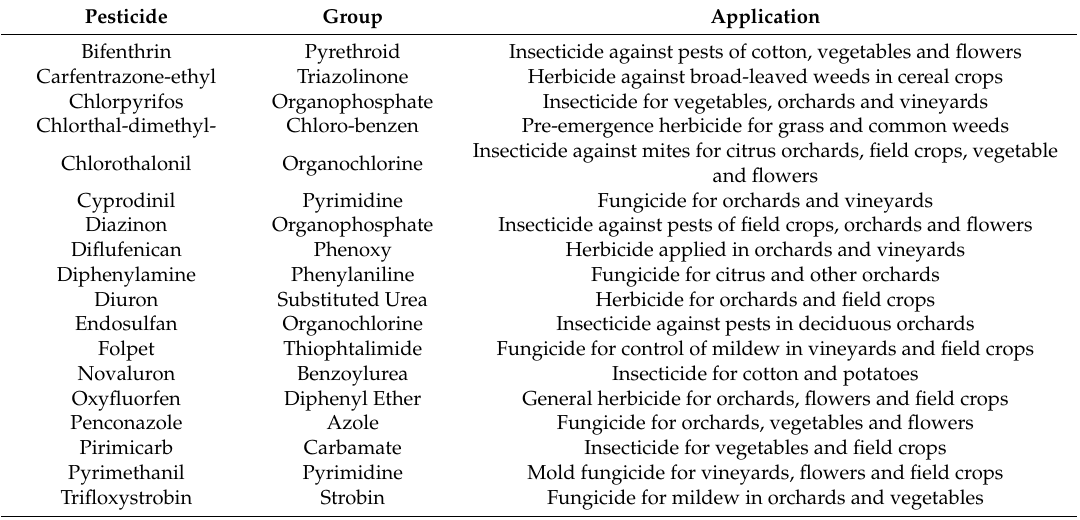
Fungicide for mildew in orchards and vegetables Not all the aeolian dust samples were found to contained pesticides (Tables A1 and A2).